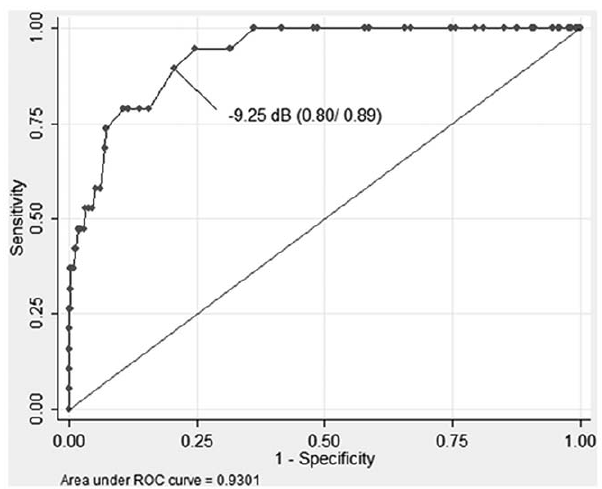
Figure 1. Receiver operating curve for SNR in comparison to PTA . 40 dB. The receiver operating curve plots the specificity versus the sensitivity of the Speech-to-noise ratio in comparison to hearing ability measured by the pure-tone average . 40 dB.